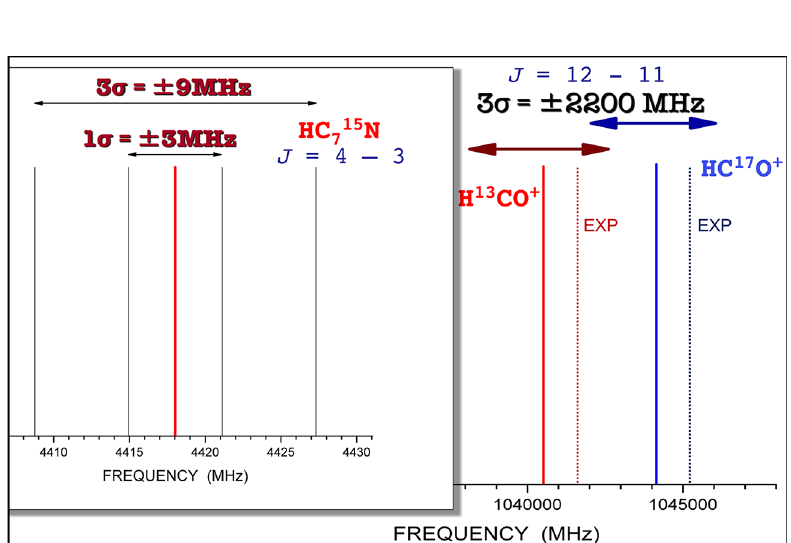
Fig. 2. – On the left: the J = 4 ← 3 rotational transition of the main isotopic species of HC 5 N. On the right: the J = 12 ← 11 rotational transition of H 13 CO + and HC 17 O +